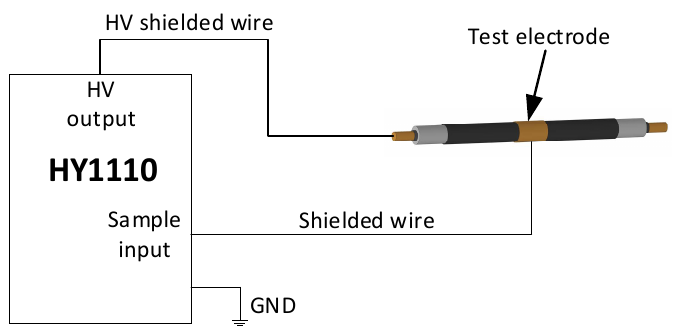
Figure 2. The cable capacitance and dielectric loss factor measurement device.